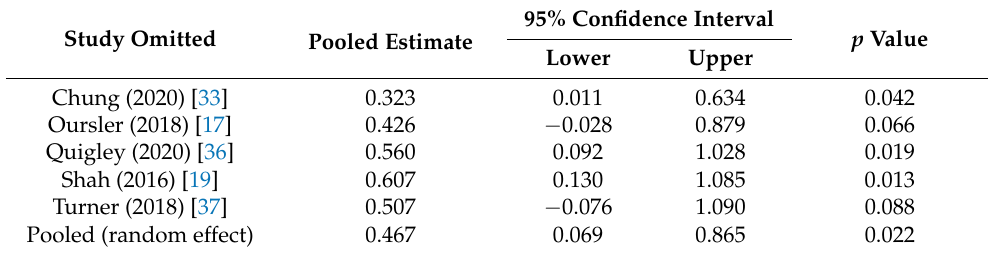
Table 4. Sensitivity analysis for walking capacity excluding each study one by